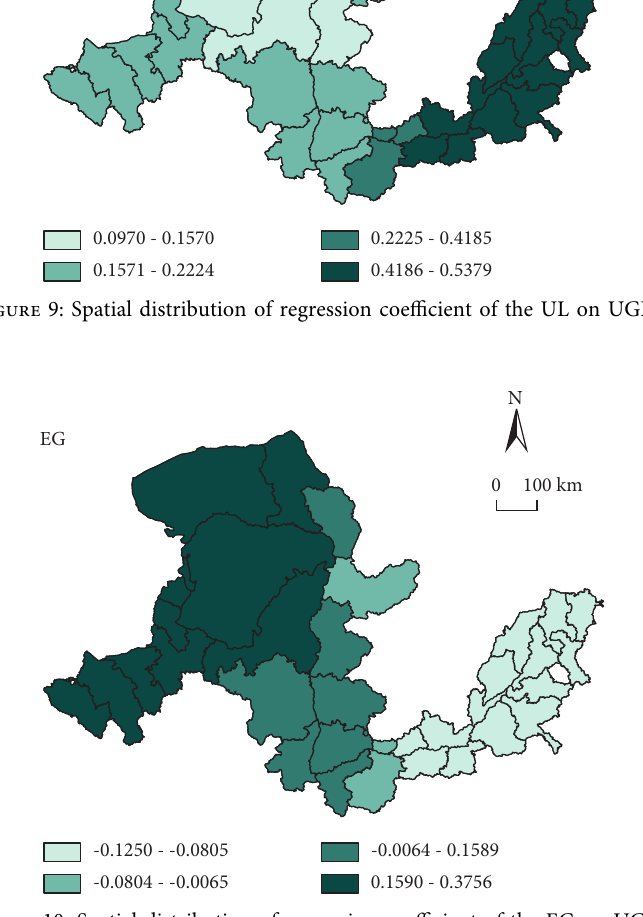
Figure 10: Spatial distribution of regression coefficient of the EG on